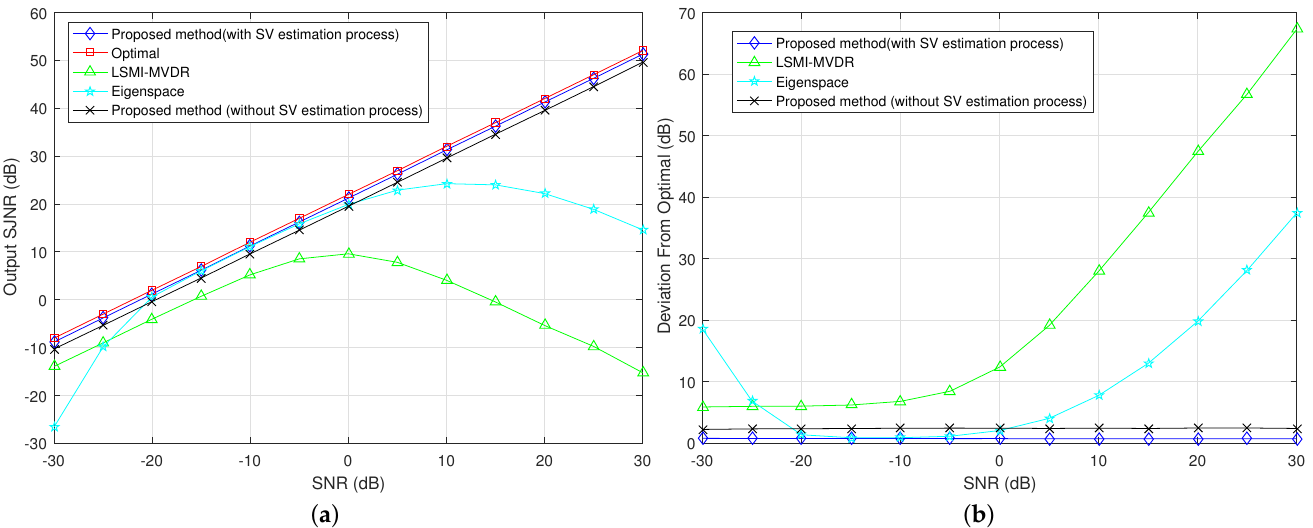
Figure 6. SJNR output performance of different methods. ( a ) Output SJNR versus input signal-to-noise ratio (SNR) ( b ) output SJNR deviation from the optimal